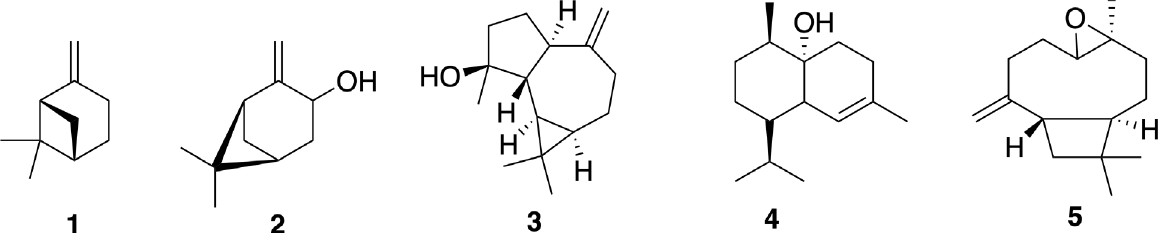
Figure 1. Chemical structures of the major compounds from Schinus molle essential